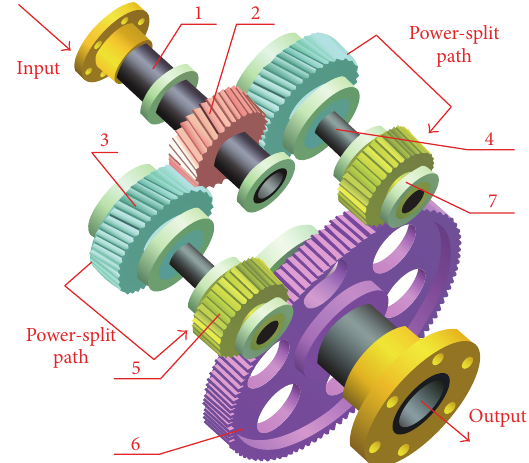
Figure 1: Example of a power-split transmission design with power paths. Illustration of (1) input shaft, (2) I-stage helical pinion, (3) I-stage helical gear, (4) torsion shaft, (5) II-stage spur pinion, (6) II- stage spur gear, and (7) II-stage spur pinion.